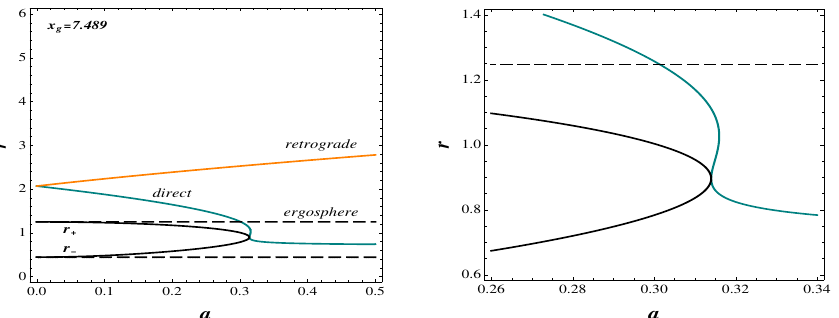
Figure 3. Photon orbits, horizons, and ergospheres dependently on a ( left ) and the enlarged image near the double horizon ( right